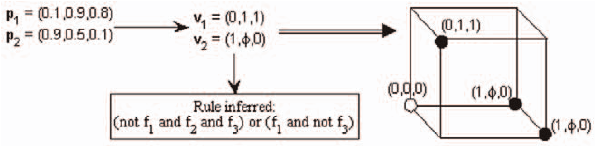
Figure 2. Rule generation: an example with two mixtures [ 32 ] . p 1 and p 2 are probability vectors thresholded to main vectors v 1 and v 2 , which in turn are mapped onto the corners of a hypercube. A rule is automatically derived from the main vectors and is shown in the box.